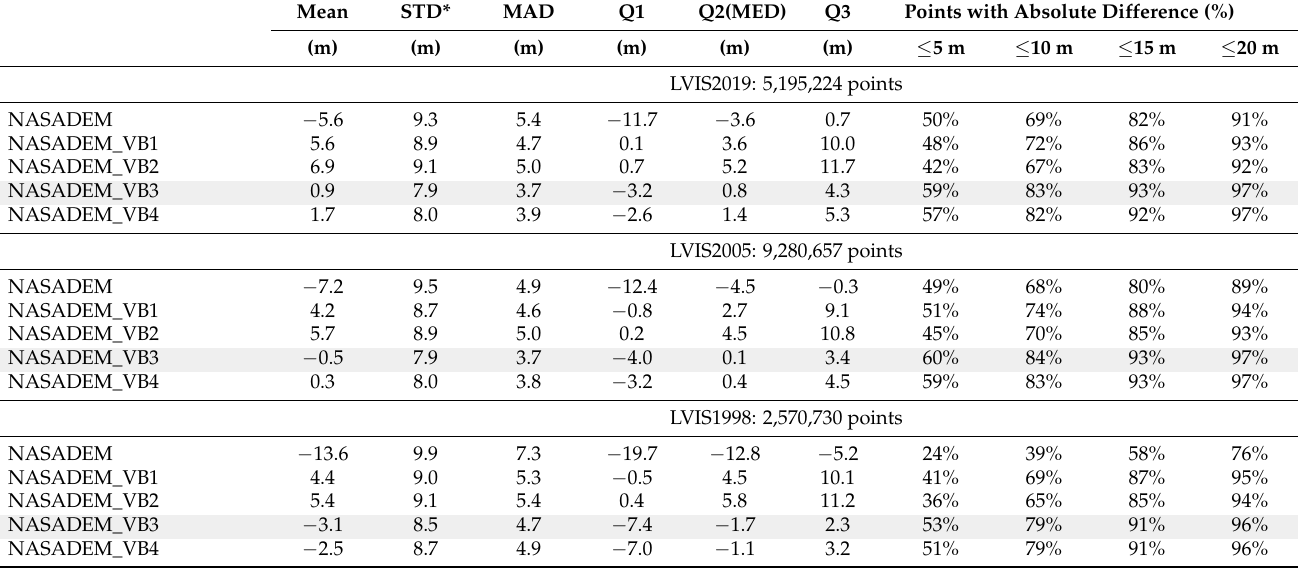
Figure 11. Results of the correction of NASADEM for Vegetation Bias (VB), as compared to LVIS data from 2019 (red), 2005 (blue), and 1998 (orange). ( a ) Distribution and statistics for the original NASADEM. ( b – e ) Distribution and statistics for NASADEM corrected by VB Models 1–4, respec- tively. The statistics is provided in terms of the Median Difference (MED) and Median Absolute Difference (MAD). Table 3. Statistics of the differences between LVIS data from 2019, 2005, and 1998 and heights interpolated for original NASADEM and NASADEM corrected by four vegetable bias models. The statistics is provided in terms of the mean difference, Standard Deviation (STD*) for differences without outliers larger than ± 50m, Median Absolute Difference (MAD), 25th empirical quartile Q1, the Median (MED) or the 50th empirical quartile Q2, the 75th empirical quartile Q3, and percentages of points having absolute differences below certain